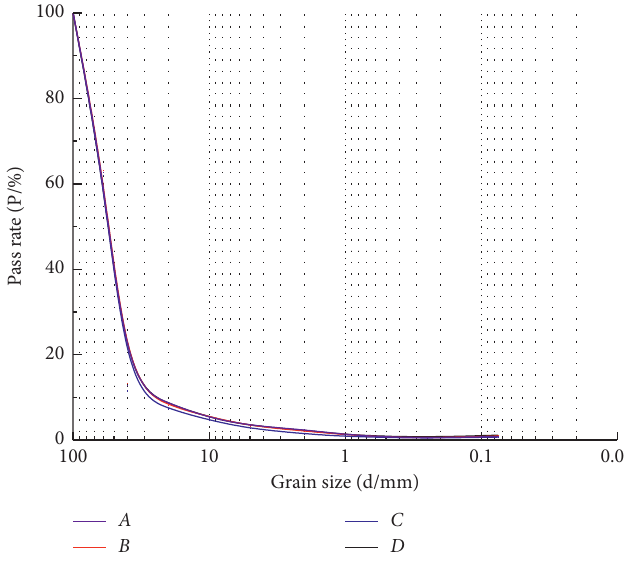
Figure 3: The grain size distribution curves at the site of A, B, C, and D . Table 3: Physical and mechanical properties of soil.